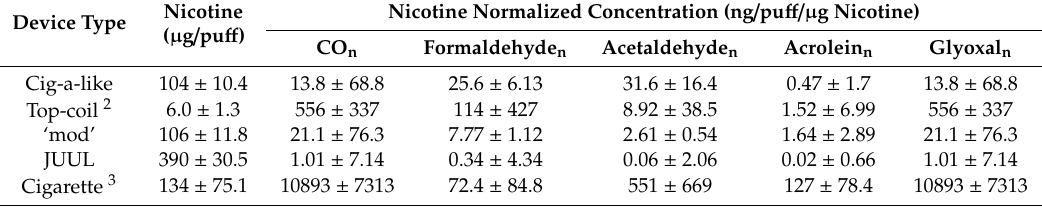
Table 3. Nicotine ( µ g / pu ff ) and nicotine-normalized CO (CO n ), formaldehyde (formaldehyde n ), acetaldehyde (acetaldehyde n ), acrolein (acrolein n ), and glyoxal (glyoxal n ) concentrations (ng / pu ff/ µ g nicotine) for four tested e-cigarettes. Values for conventional cigarettes are given for comparison 1